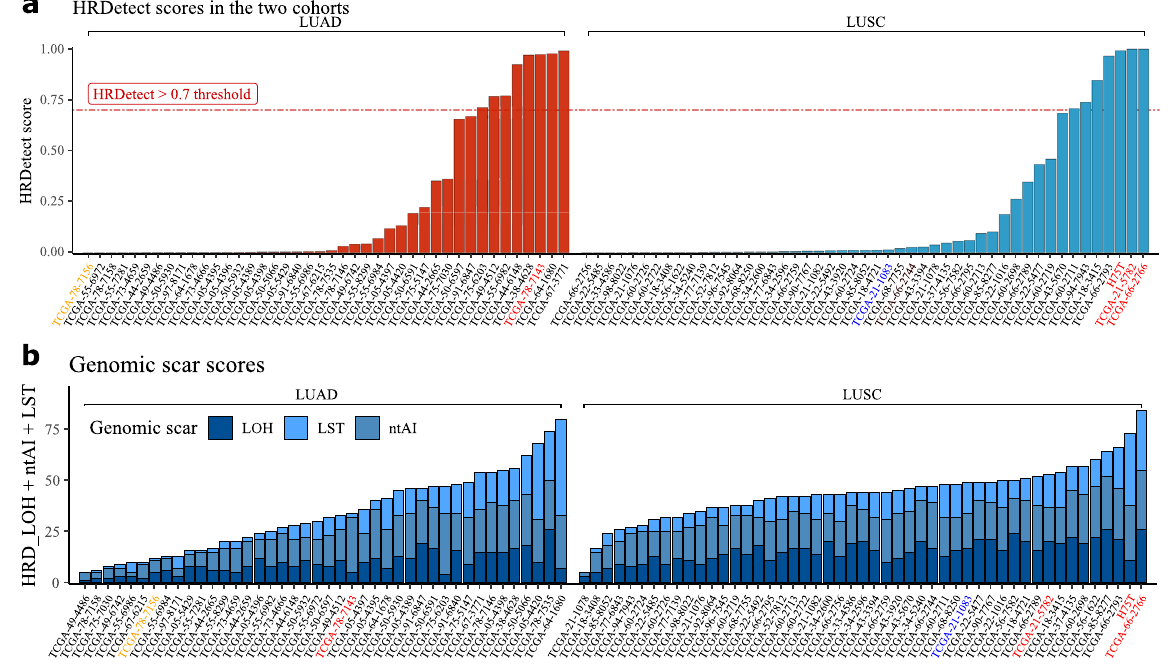
Fig. 2 HRD scar scores and HRDetect scores of the LUAD and LUSC WGS datasets. In both panels, the sample names are colored according to their genotypes: yellow — BRCA2 heterozygote mutant, red — BRCA2 homozygote mutant, blue – BRCA1 heterozygote mutant. a HRDetect scores calculated using the original, breast cancer whole-genome-based HRDetect weights by following the original article ’ s standardization and attribute-transformation strategies 12 . b The total sum of the genomic scar scores (HRD-LOH, LST, and ntAI) determined from the LUAD and LUSC whole cancer genome ’ s allele-speci fi c copy-number pro fi